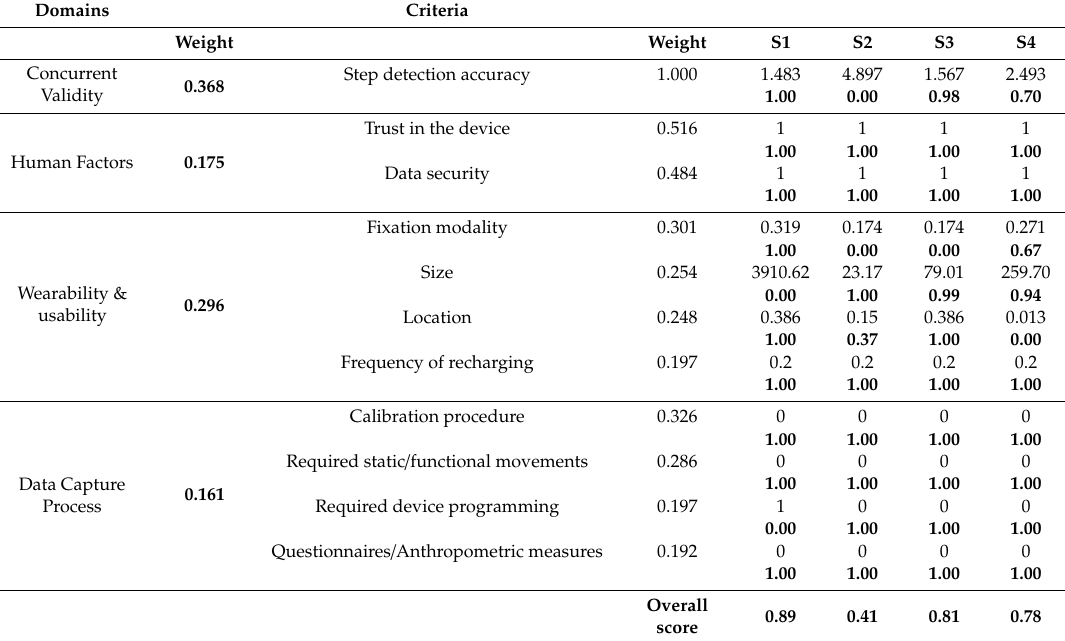
Table 4. Evaluation matrix applied to four wearable devices. Normalised scores are reported in bold.